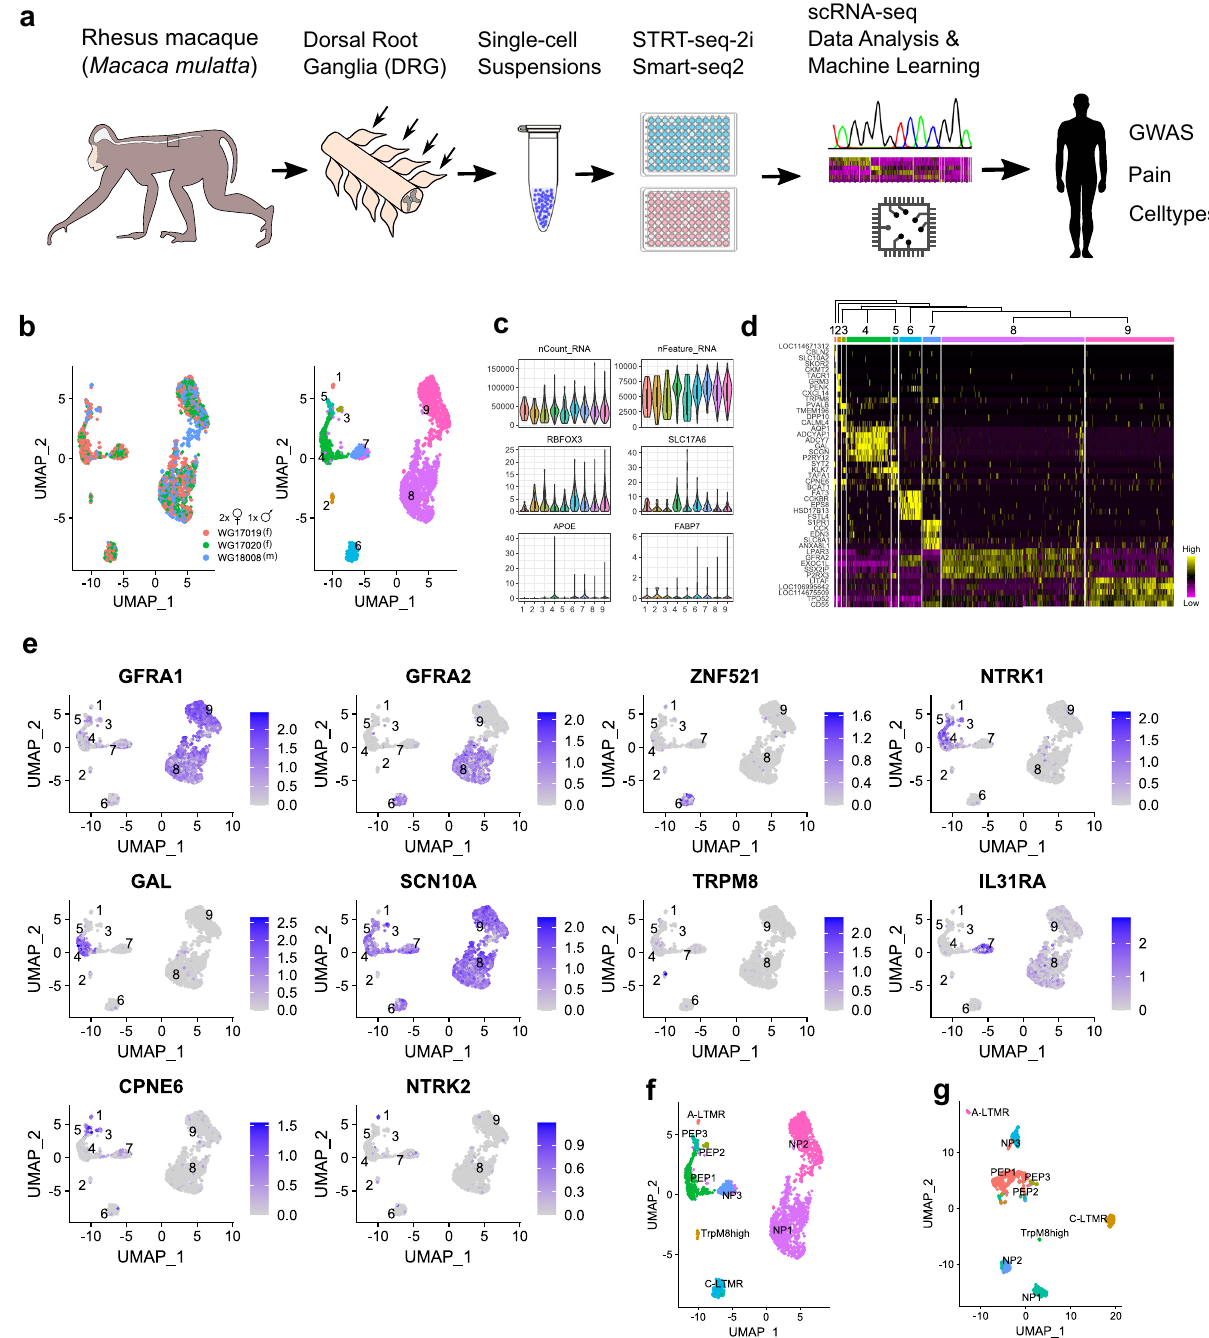
Fig. 1 Somatosensory neuron clusters in the macaque DRG. a A schematic view of the work fl ow. b UMAP plots showing (left) the contribution of individual animals ( N = 3) to STRT-2i-seq clusters and (right) fi nal cluster numbers (m = male, f = female). c Violin plots showing total counts of unique transcripts, detected genes, and transcript counts for neuronal and satellite-glia marker genes in the neuronal clusters. Y -axes show detected genes per cell for nFeature_RNA; all others are raw UMI counts. Boxplot de fi nes the median, interquartile range (IQR), and 1.5 × IQR (whiskers). d A hierarchically organized heatmap with the fi ve most speci fi c genes (by p -adj) for each cluster. e UMAPs showing mouse canonical marker gene expression in the STRT- 2i-seq macaque clusters. f STRT-2i-seq macaque clusters named after most likely mouse counterparts. g Named Smart-seq2 clusters after label transfer from the STRT-2i-seq data. Image sources: freevectors.net (human silhouette), needpix.com (microwell plates), openclipart.org (Eppendorf tube). (Supplementary Fig. 2e, f). Tentative neuron identities for this datasets (Supplementary Fig. 2h); thus, representing an independent dataset were assigned in a supervised manner using the STRT-2i-seq identi fi cation of the cell types identi fi ed in the STRT-2i-seq data. For data as a reference (Fig. 1f, g and Supplementary Fig. 2g). full marker lists from both scRNA-seq datasets, see Supplementary Interrogation of marker gene expression used for tentative cell- Data 1 and 2. An interactive web resource for browsing the datasets type assignment showed identical patterns between the two macaque is available at https://ernforsgroup.shinyapps.io/macaquedrg/.